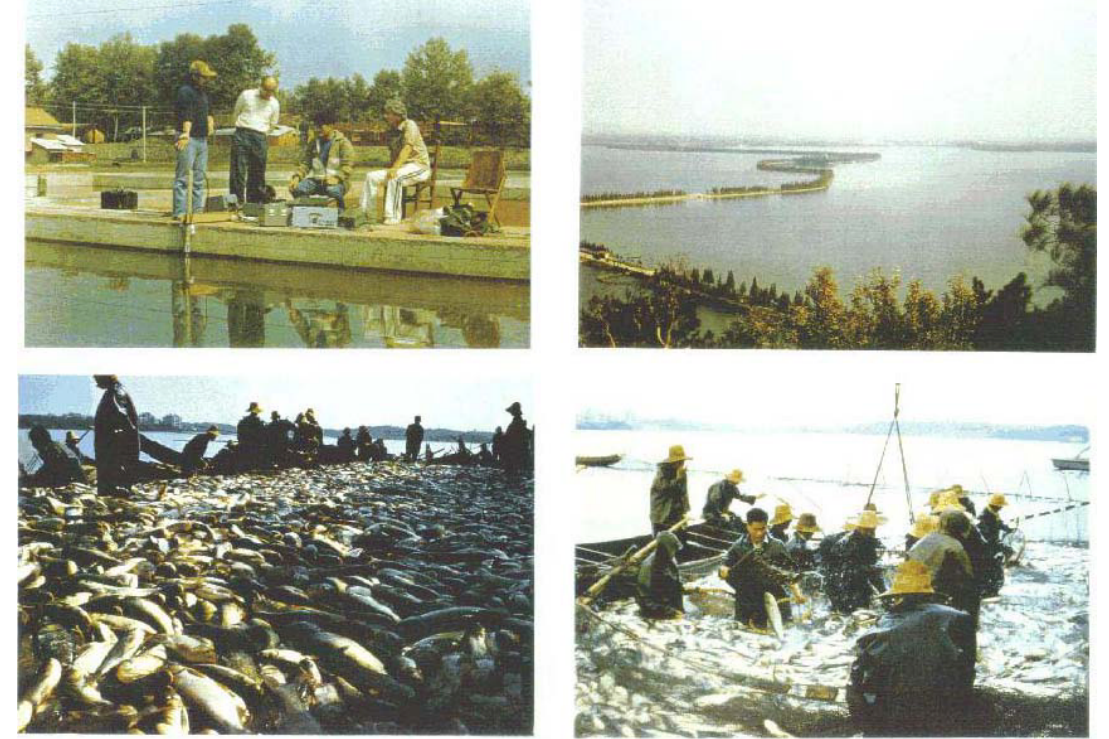
FIGURE 8. The harvested silver carp and bighead (lower left), the bulk harvesting by the fishermen (lower right), testing of echo- sounder ashore a fish pond (upper left) by scientists to estimate fish population of the lake, and the artificial dikes across Lake Donghu (upper right) (photos by K.